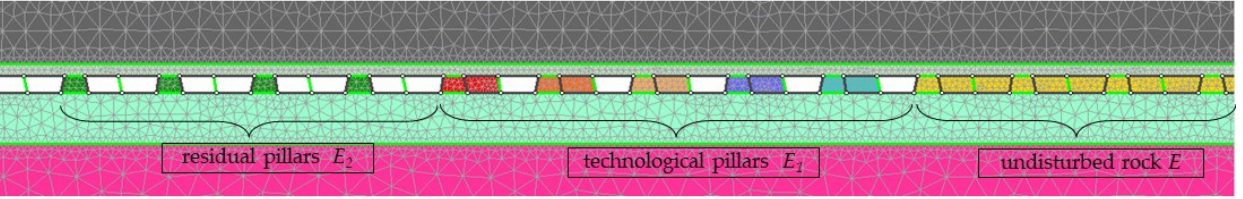
Figure 9. Chart of convergence determined numerically for chosen excavation in D-IE mining field for different combinations of parameter values assumed for pillars.